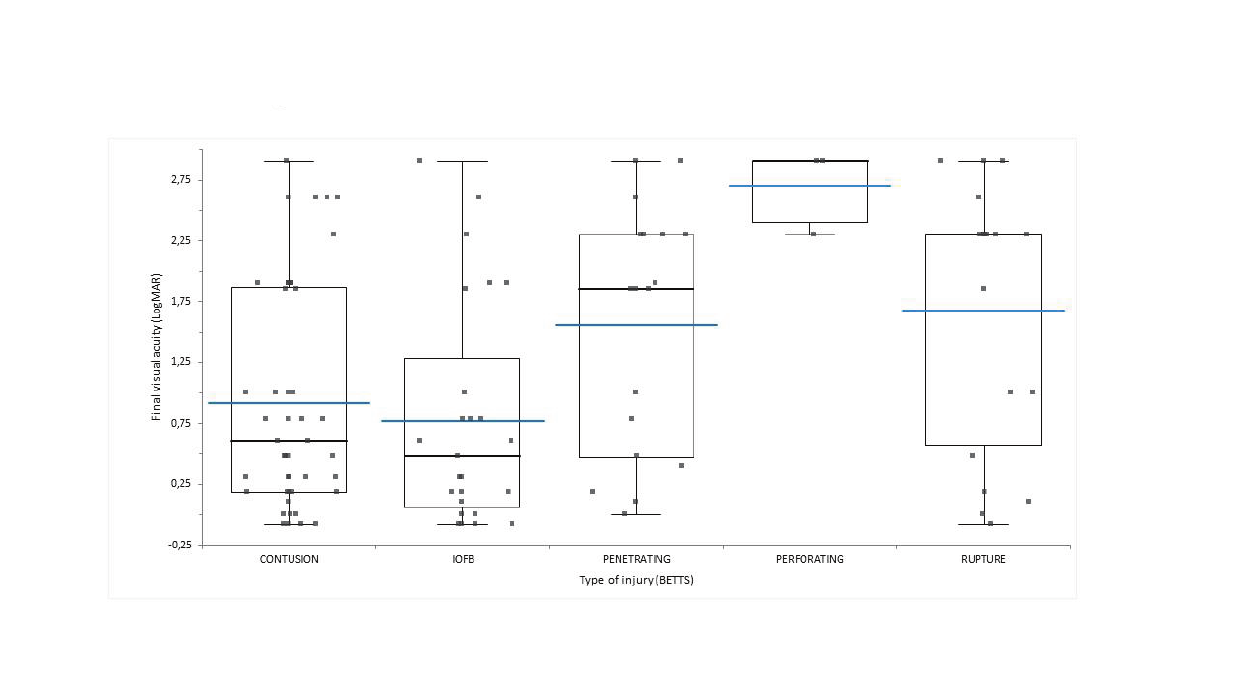
Figure 2. Combined stacked scatterplots and box plots of final visual acuity outcomes in each BETTS classified type of injury. Shown are stacked scatterplots and box plots for contusion injuries (45 eyes), intraocular foreign bodies (25 eyes), penetrating injuries (18 eyes), perforating injuries (3 eyes), and globe rupture (19 eyes). Box plots with box spanning interquartile range with maximum and minimum values (excluding outliers) are provided. Black and blue lines represent median and mean,